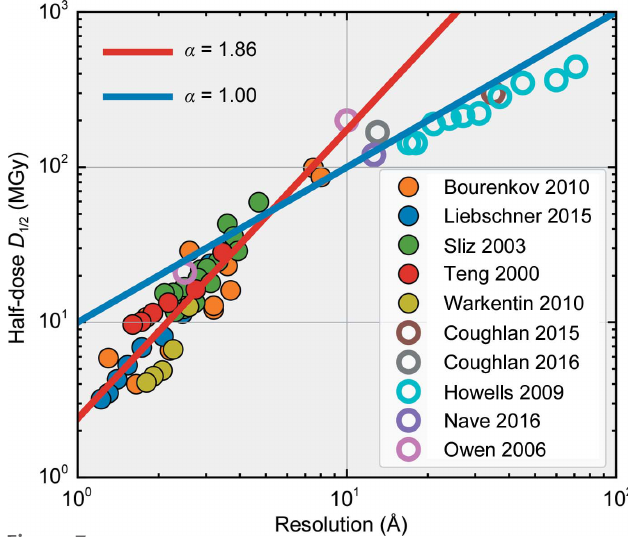
Figure 7 Experimental half-doses versus resolution obtained from several previous crystallographic studies (Bourenkov & Popov, 2010; Liebschner et al. , 2015; Sliz et al. , 2003; Teng & Moffat, 2000; Warkentin & Thorne, 2010; Coughlan et al. , 2015, 2016; Howells et al. , 2009; Nave et al. , 2016; Owen et al. , 2006), analyzed accounting for their dose distribution (solid circles) or used as reported (open circles). Aside from the data of Howells et al. (2009) at resolution beyond 10 A˚ , the overall trend is in good agreement with (cid:2) = 2, with a best-fit exponent of